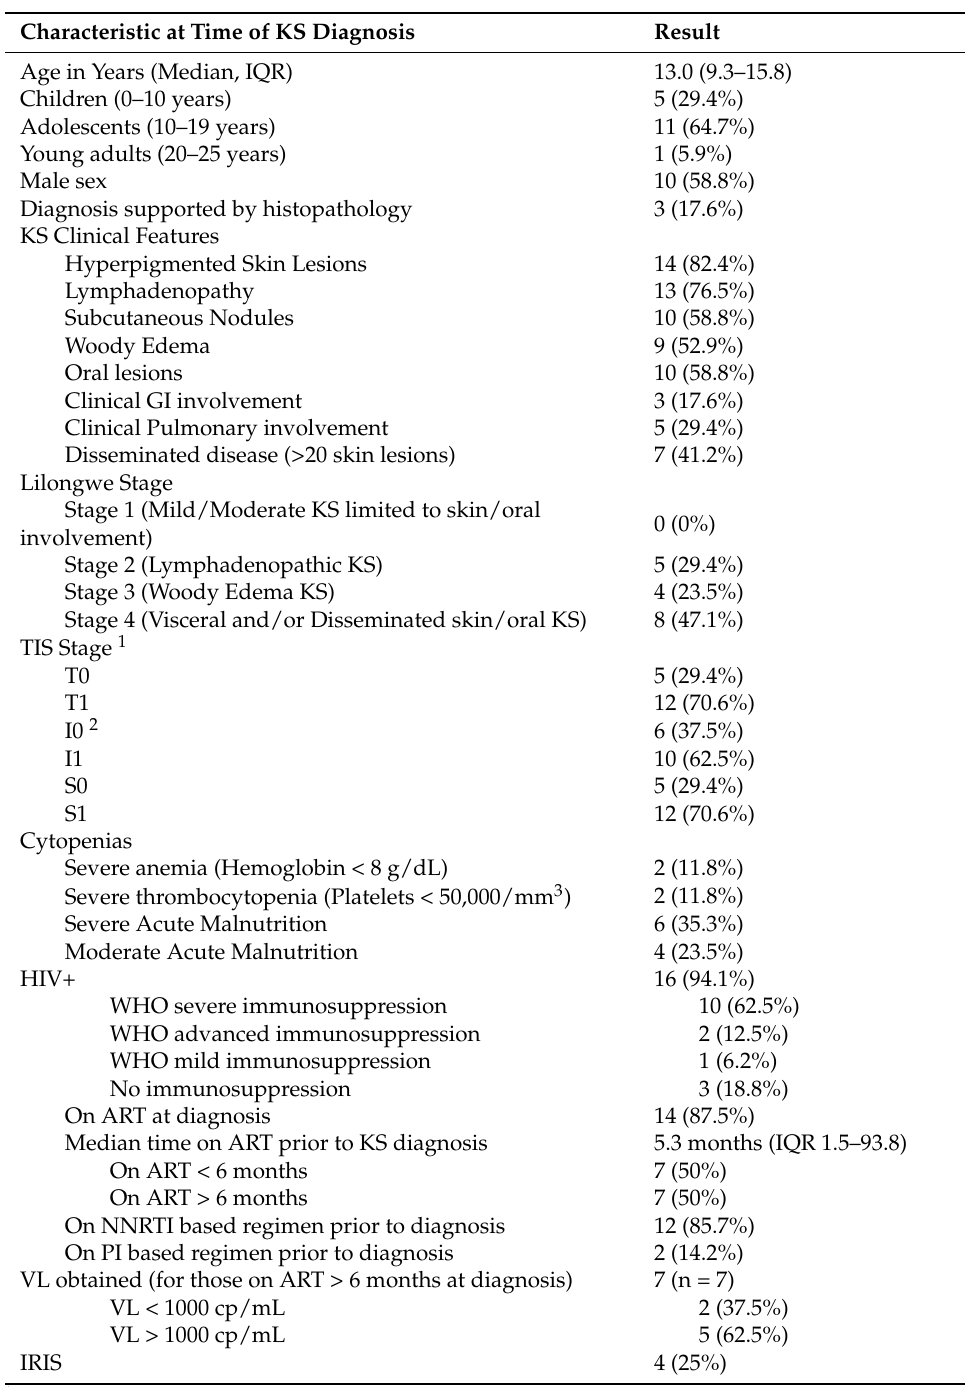
Table 1. Demographic and clinical characteristics of children and adolescents, and young adults who were treated with paclitaxel at time of KS diagnosis ( n =